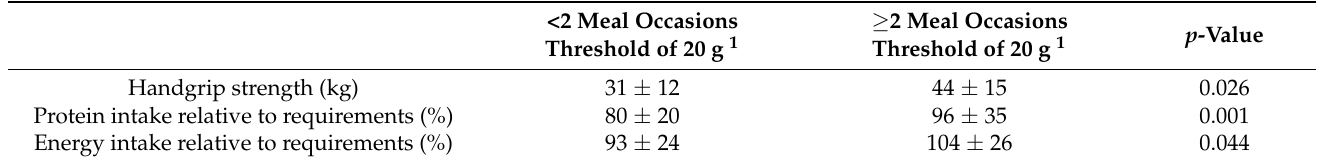
Table 2. ANCOVA 2 analysis for the difference in handgrip strength between participants who achieved the threshold of 20 g at ≥ 2 meal occasions compared to <2 meal